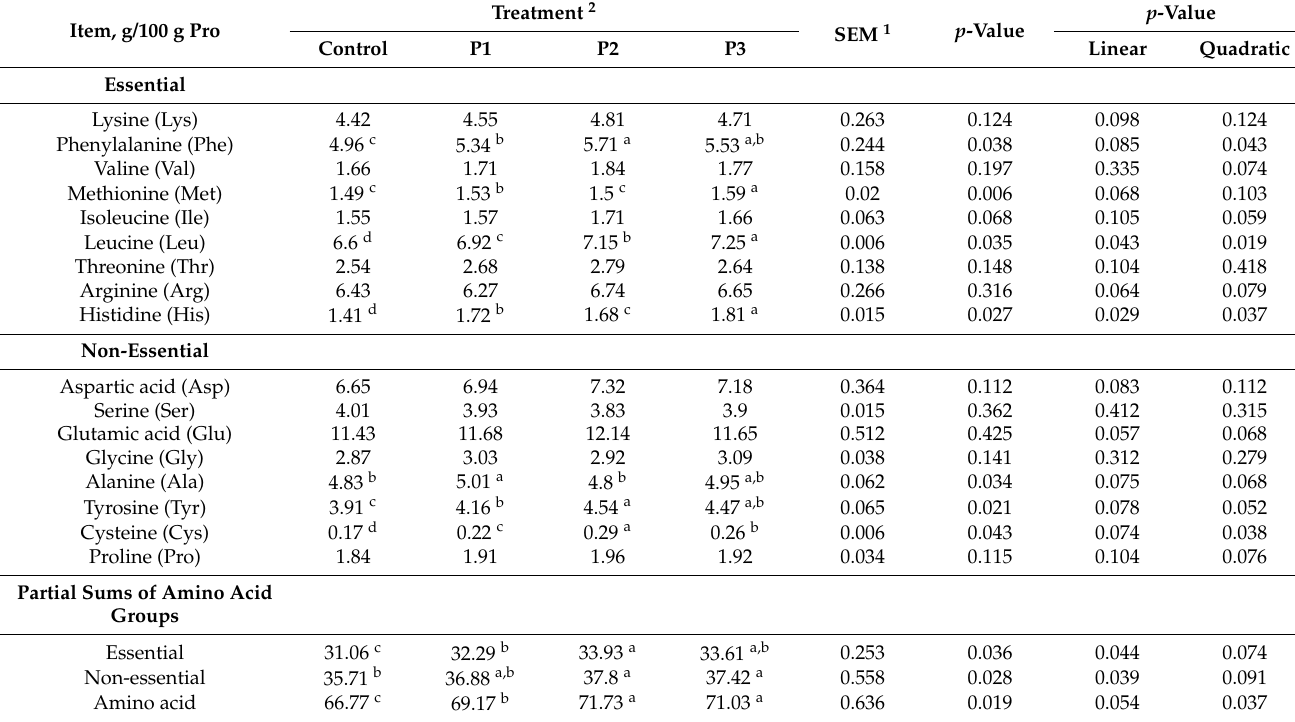
Table 4. Effect of dietary supplementation with dried jujube powder on the amino acid composition of broiler breast